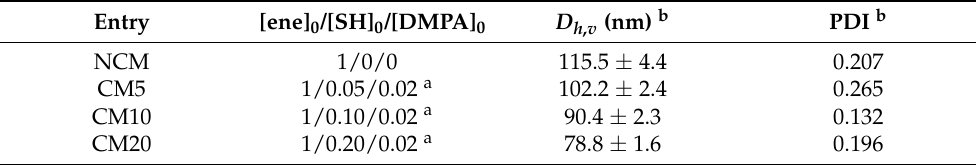
Table 2. Preparation of PEG- b -P(HEMA-ene)- b -PBA-based micelles with tunable crosslinking density at core-shell